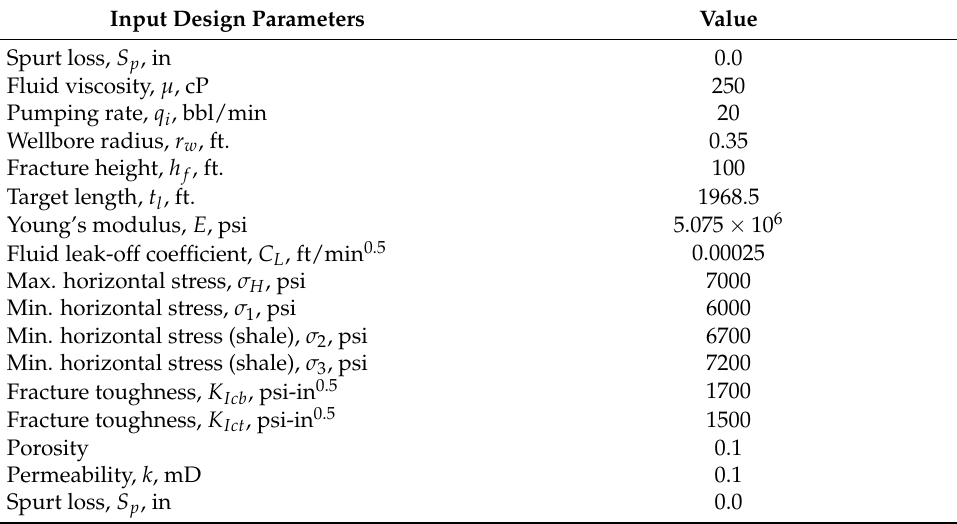
Table 3. Reservoir and well data for a single-porosity system.